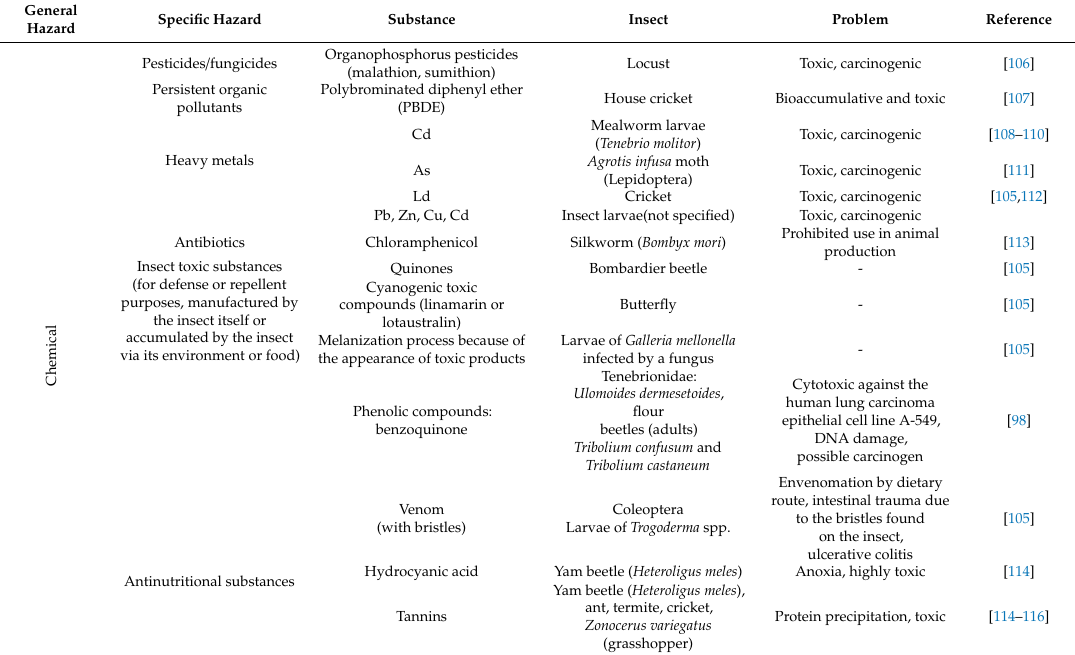
Table 7. Hazards associated with food-to-food edible insect